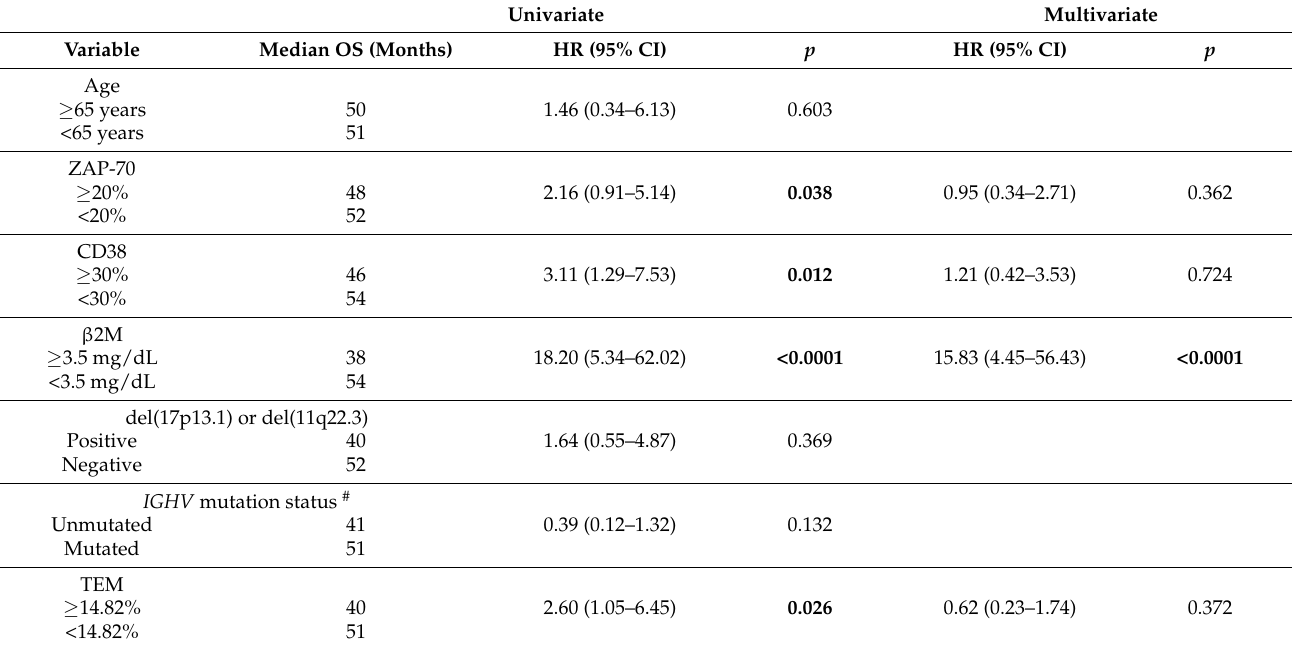
Table 4. Univariate and multivariate analysis for overall